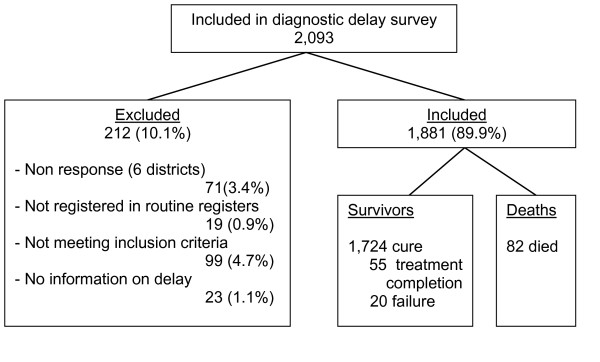
Inclusion of patients.